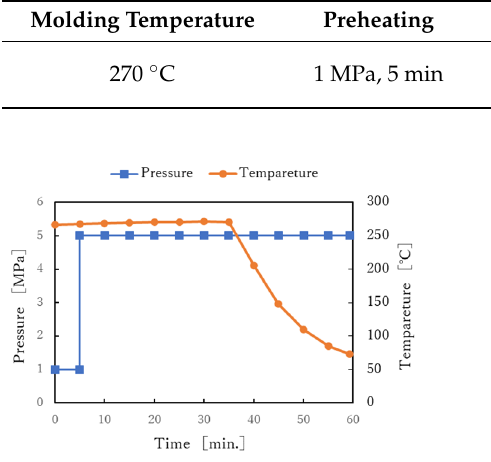
Table 4. Press molding conditions.